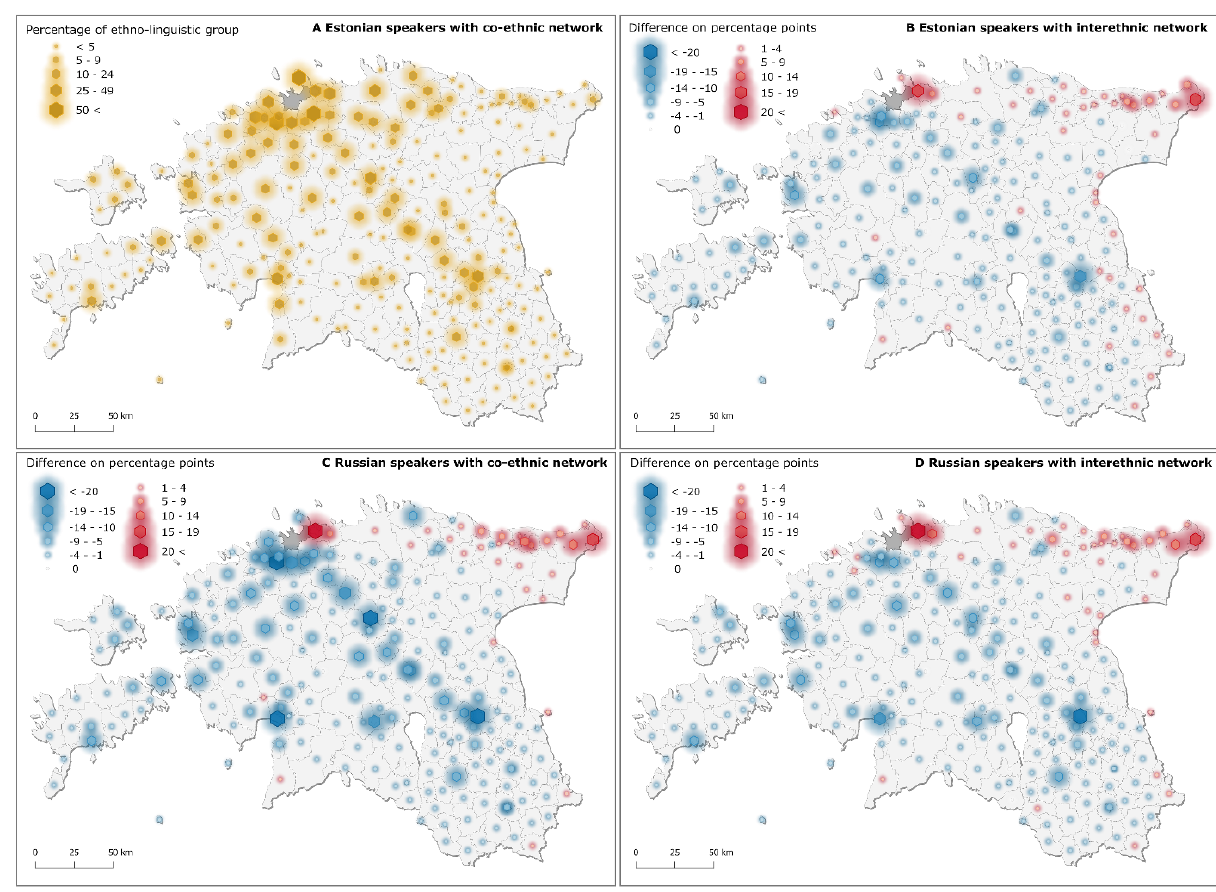
Figure 4. Comparison of visited districts in Estonia by ethno-linguistic background and network composition: (A) Estonian speakers with co-ethnic networks (reference category), (B) Estonian speakers with interethnic networks, (C) Russian speak- ers with co-ethnic networks, and (D) Russian speakers with interethnic networks. Differences are presented as percentage points (weighted